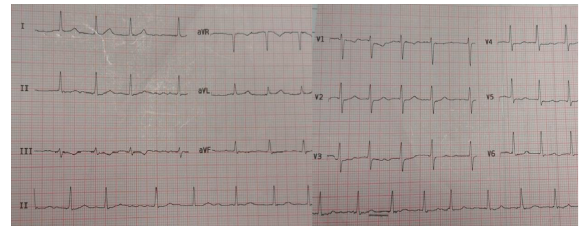
Figure 1: ECG showing atrial fibrillation